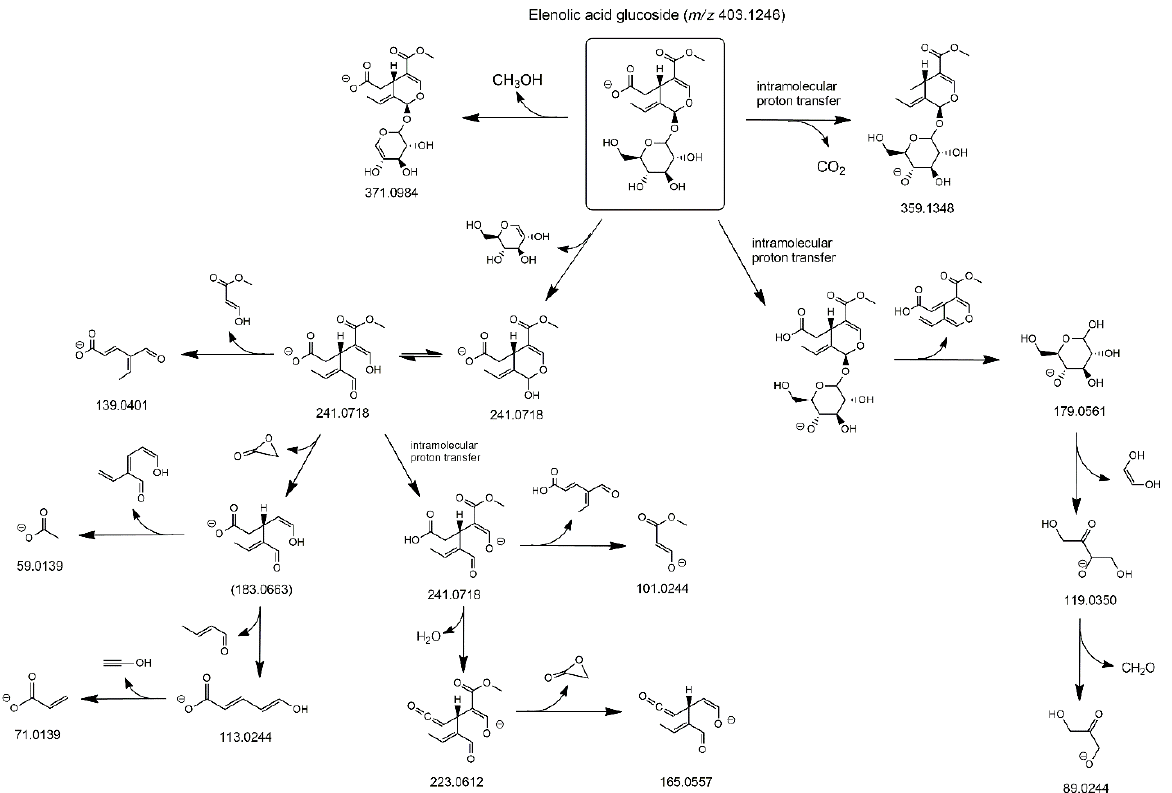
Scheme 3. Fragmentation pathways proposed to explain MS/MS data obtained for deprotonated elenolic acid glucoside detected in extracts of Coratina leaves and drupes. The m / z ratio reported in parentheses (183.0663) correspond to a fragment that was not detected, although being an intermediate for further product ions.